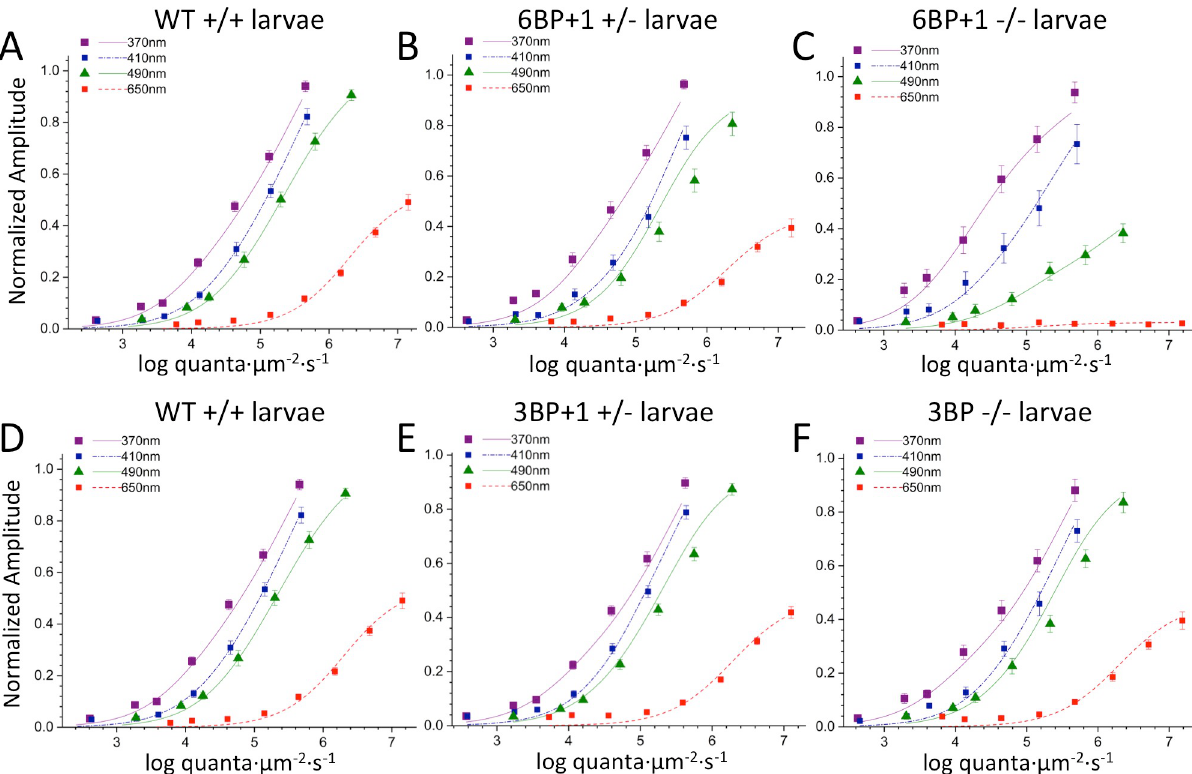
Fig 9. Irradiance plots: Change in amplitude of arval cone PIII ERG responses as a function of brightness and wavelength. (A, B) The wild type (N = 17 datasets, 1190 points total) and 6BP+1 heterozygote (N = 16 datasets, 1120 points total) irradiance-amplitude curves are similar at 4 modeled wavelengths, while the 6BP+1 mutant (N = 12 datasets, 840 points total) (C) shows a loss of response to 650 nm that does not change even at higher irradiance levels. (D-F) Wild type (same as in A), 3BP heterozygote (N = 33 datasets, 2310 points total), and 3BP mutant (N = 17 datasets, 1190 points total) larvae are similar in their respective irradiance